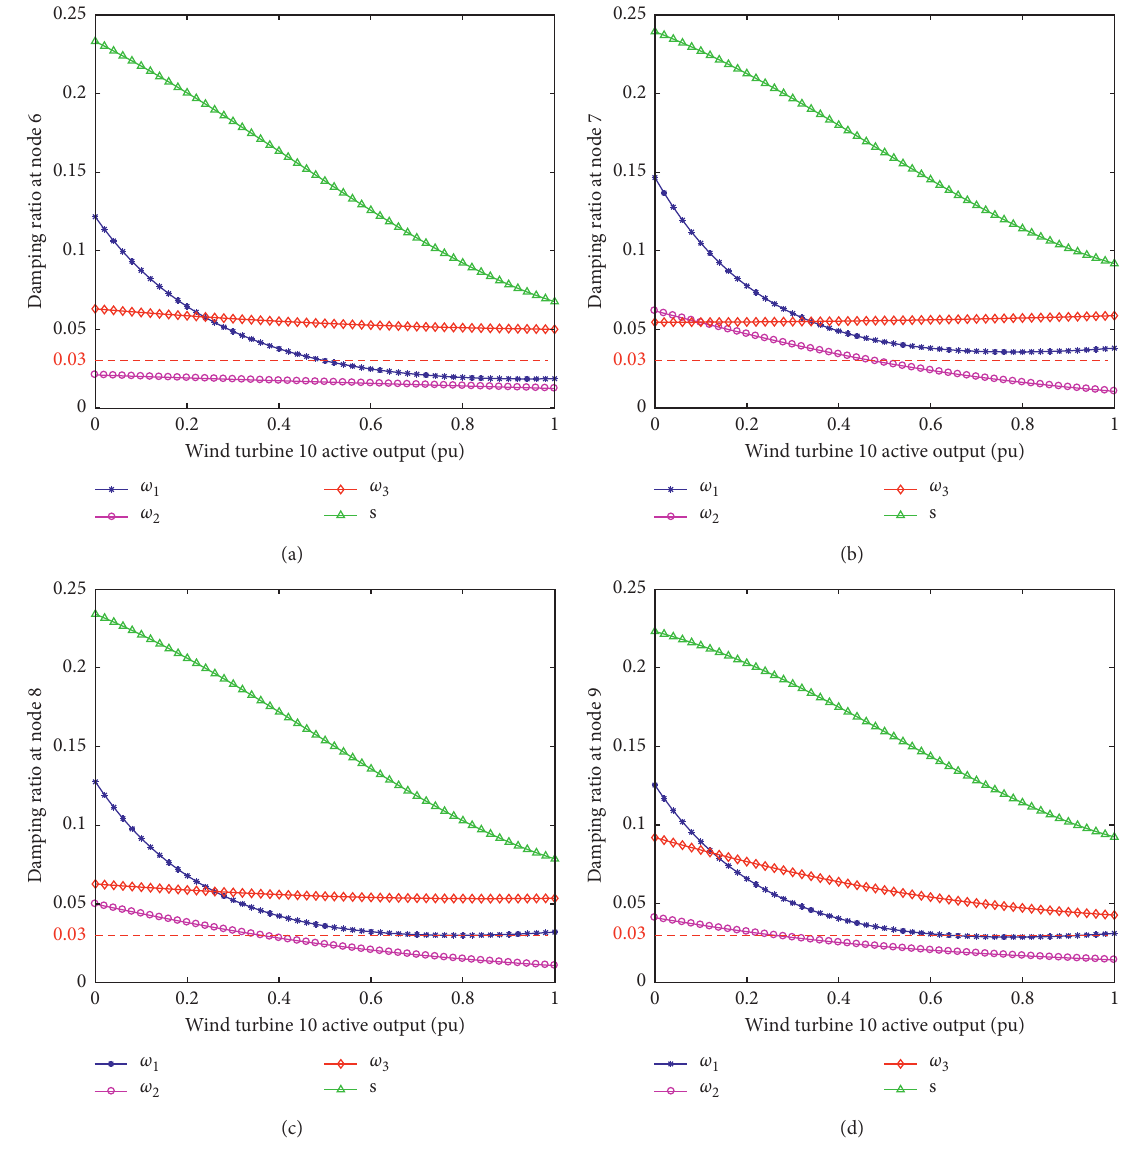
Figure 5: The damping ratio of OWF grid connection. Table 2: Corresponding components of generator speed in the right